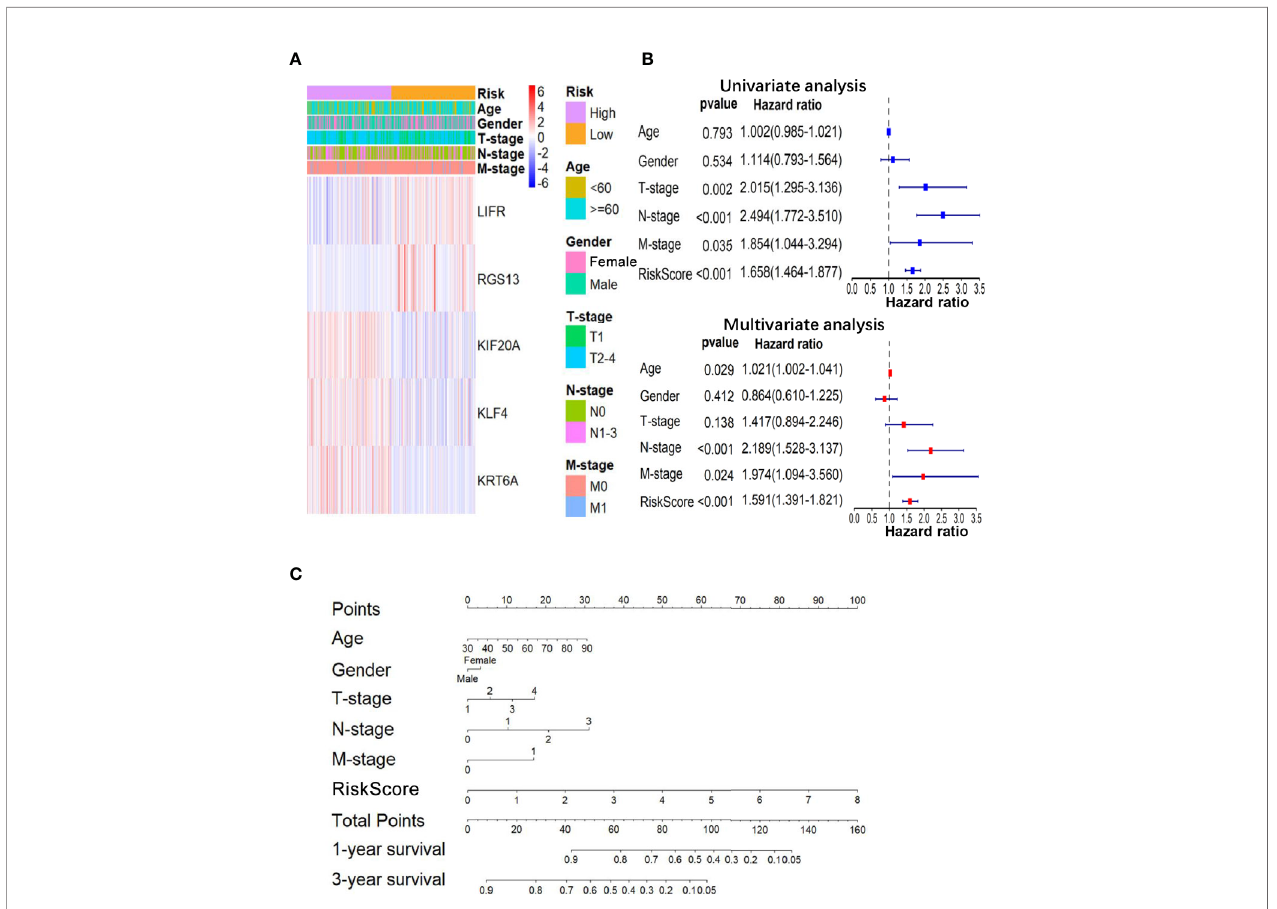
FIGURE 3 | The relationship between the 5-gene based RS and clinical information. (A) The heatmap showed the expression levels of the 5-genes in the low- and high-RS groups; The distribution of clinicopathological features was compared in low- and high-RS groups. (B) The univariate and multivariate Cox analysis for the independent 5-gene signature; (C) a nomogram was used to predict the overall survival at 1 year and 3 years with RS and clinical